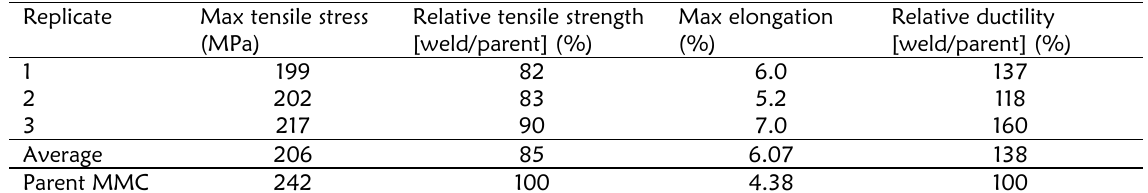
Table 6: Tensile test data for three replicates at optimal welding